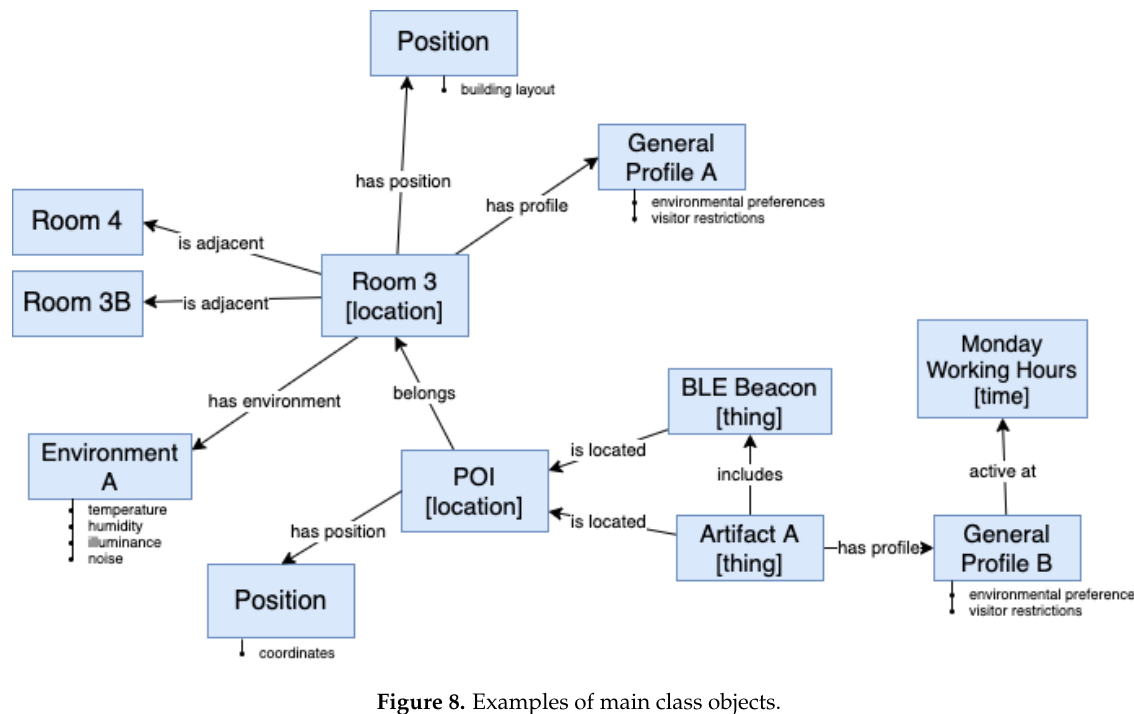
Figure 8. Examples of main class